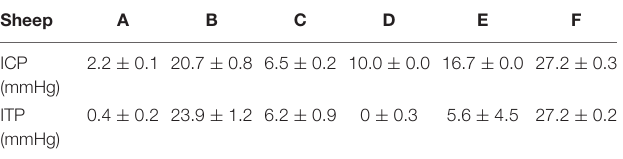
TABLE 1 | Mean cerebrospinal fluid pressures measured during a 10-min baseline.